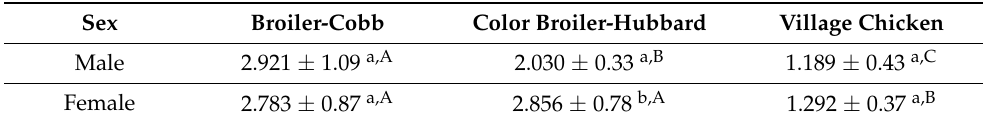
Table 4. Comparison of IMFP in different sexes in three chicken